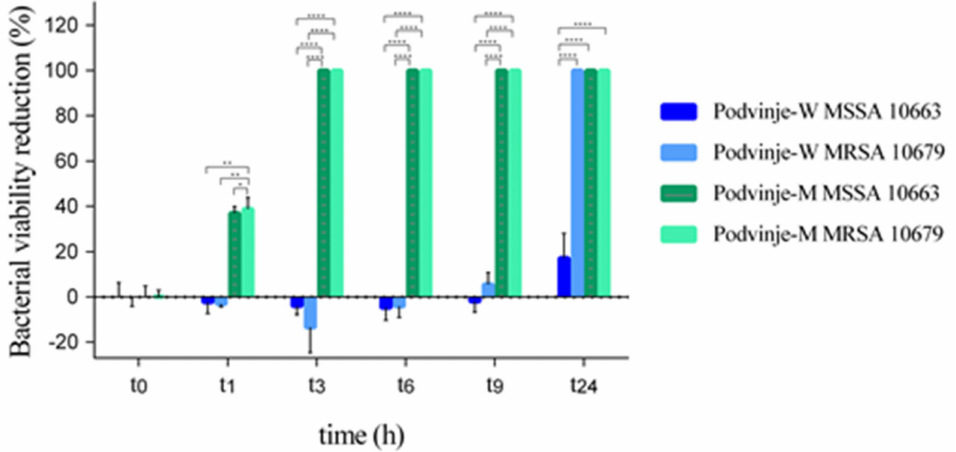
Figure 2. Bacterial viability reduction (%) in the “time-kill” assay for E. cicutarium water (Podvinje-W) and methanolic (Podvinje-M) extracts from the Podvinje locality on MSSA and MRSA strains at predefined time points t 0 , t 1 , t 3 , t 6 , t 9 i t 24 (one-way ANOVA and Tukey’s post hoc test; *, p ≤ 0.05; **, p ≤ 0.01; ****, p ≤